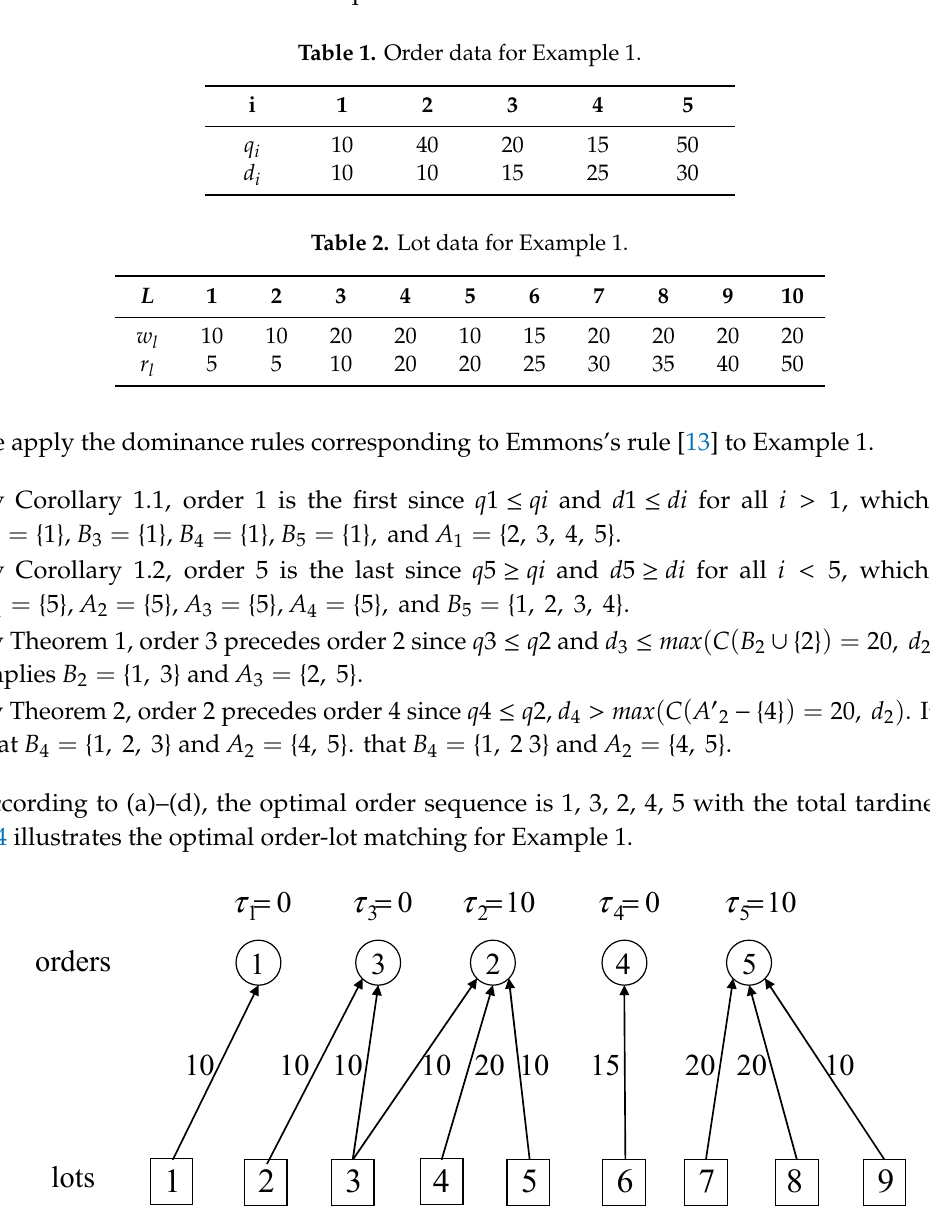
Table 3. Order data for Example 2.